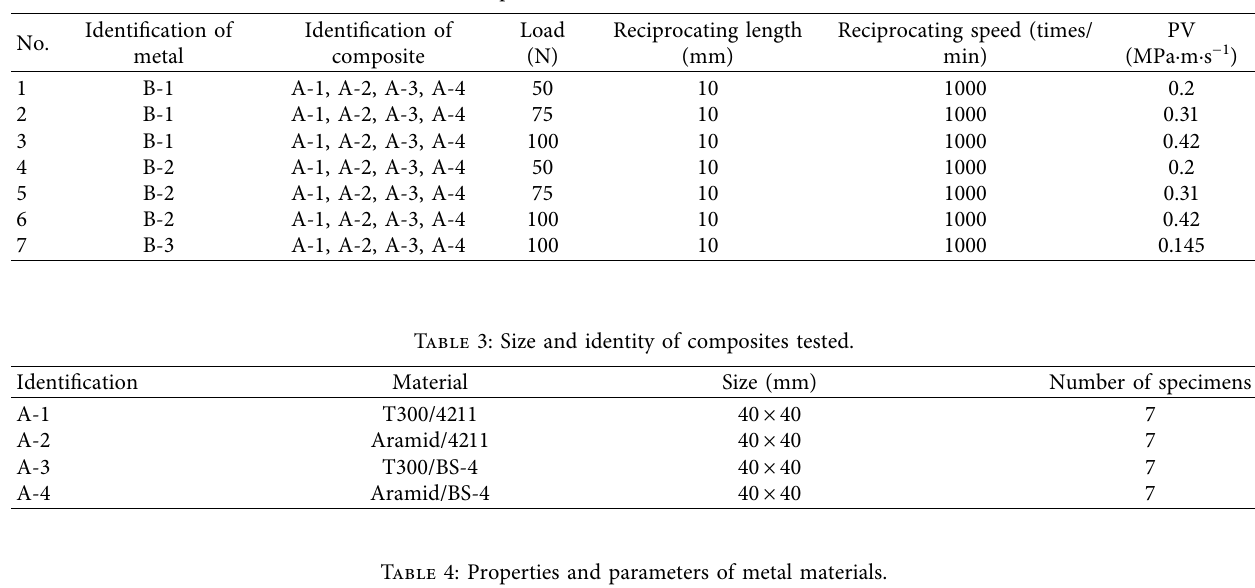
Figure 4: Sketches of (a) the instrument and (b) wear measuring instrument. (1) Lift knob; (2) lift motor; (3) lift platform; (4) left and right knot; (5) left and right translation platform; (6) 200N sensor; (7) 200N fixture; (8) metal pair fixture; (9) instrument mainframe platform; (10) reciprocating component; (11) experimental sample fixture; (12) experimental sample; (13) left and right translation motor; (14) fixing nut; (15) lift bar; (16) fixed support; (17) displacement sensor. Table 2: Experimental conditions and combinations.